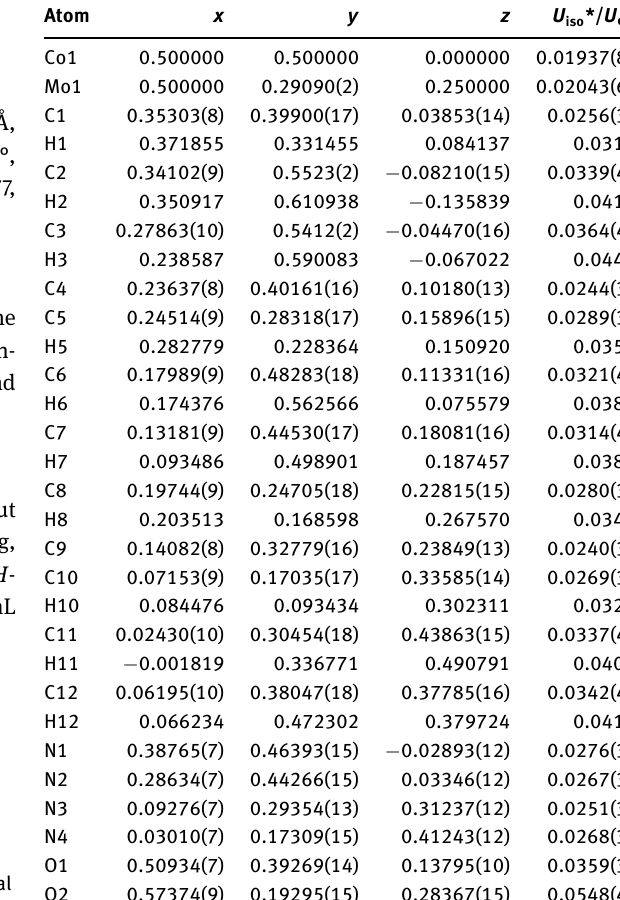
All reagents and solvents were purchased and used without further purification. A mixture of Na 2 MoO 4 · 2H 2 O (0.0484 g,